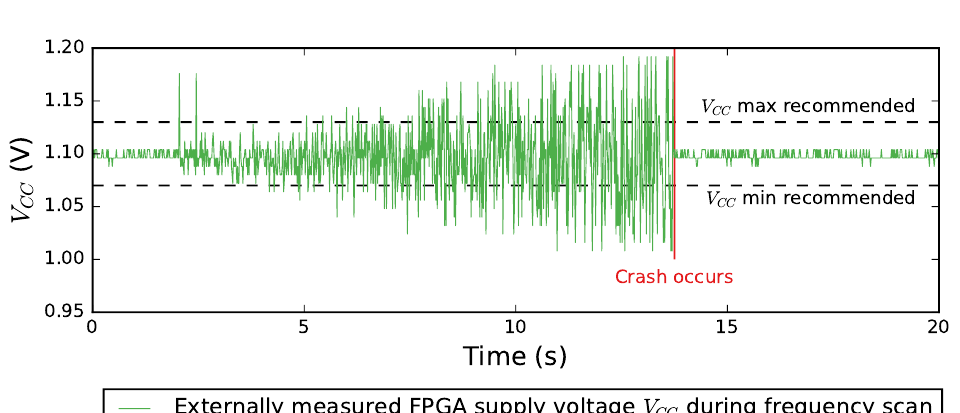
Figure 5: Trace of FPGA supply voltage VCCINT , measured externally with an oscilloscope during a frequency sweep leading to a crash of the device